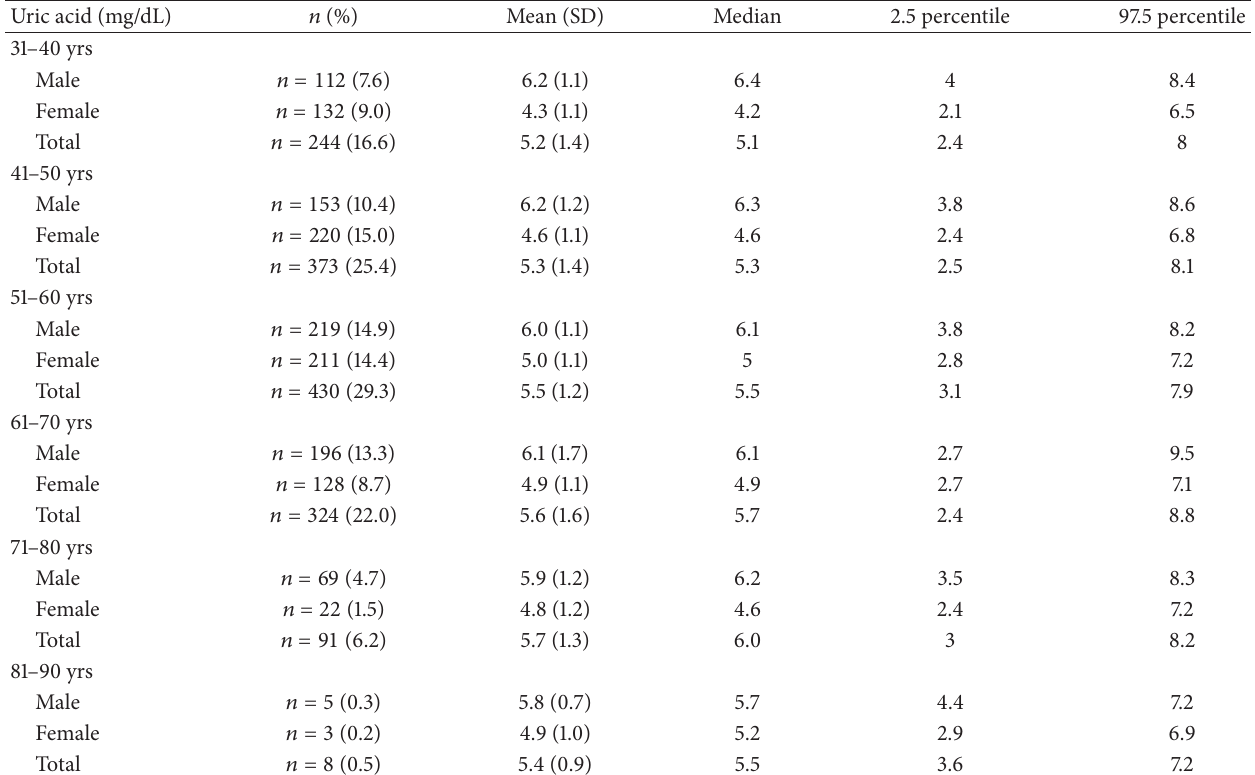
Table 6: Statistical analysis of serum uric acid according to age and